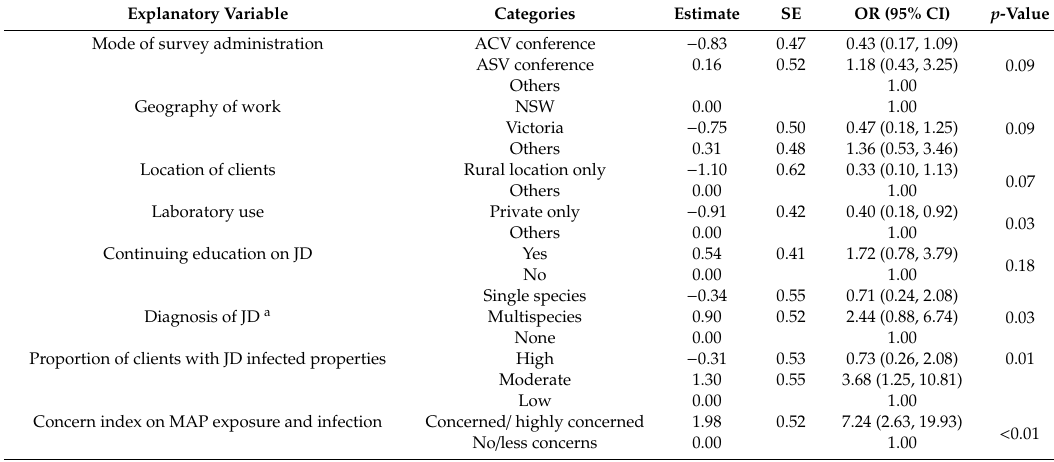
Table 3. Results of univariable ordinal logistic regression using ‘veterinarians’ perception for MAP as a causative agent of Crohn’s disease’ as an ordinal outcome based on a study conducted in Australia in 2016.